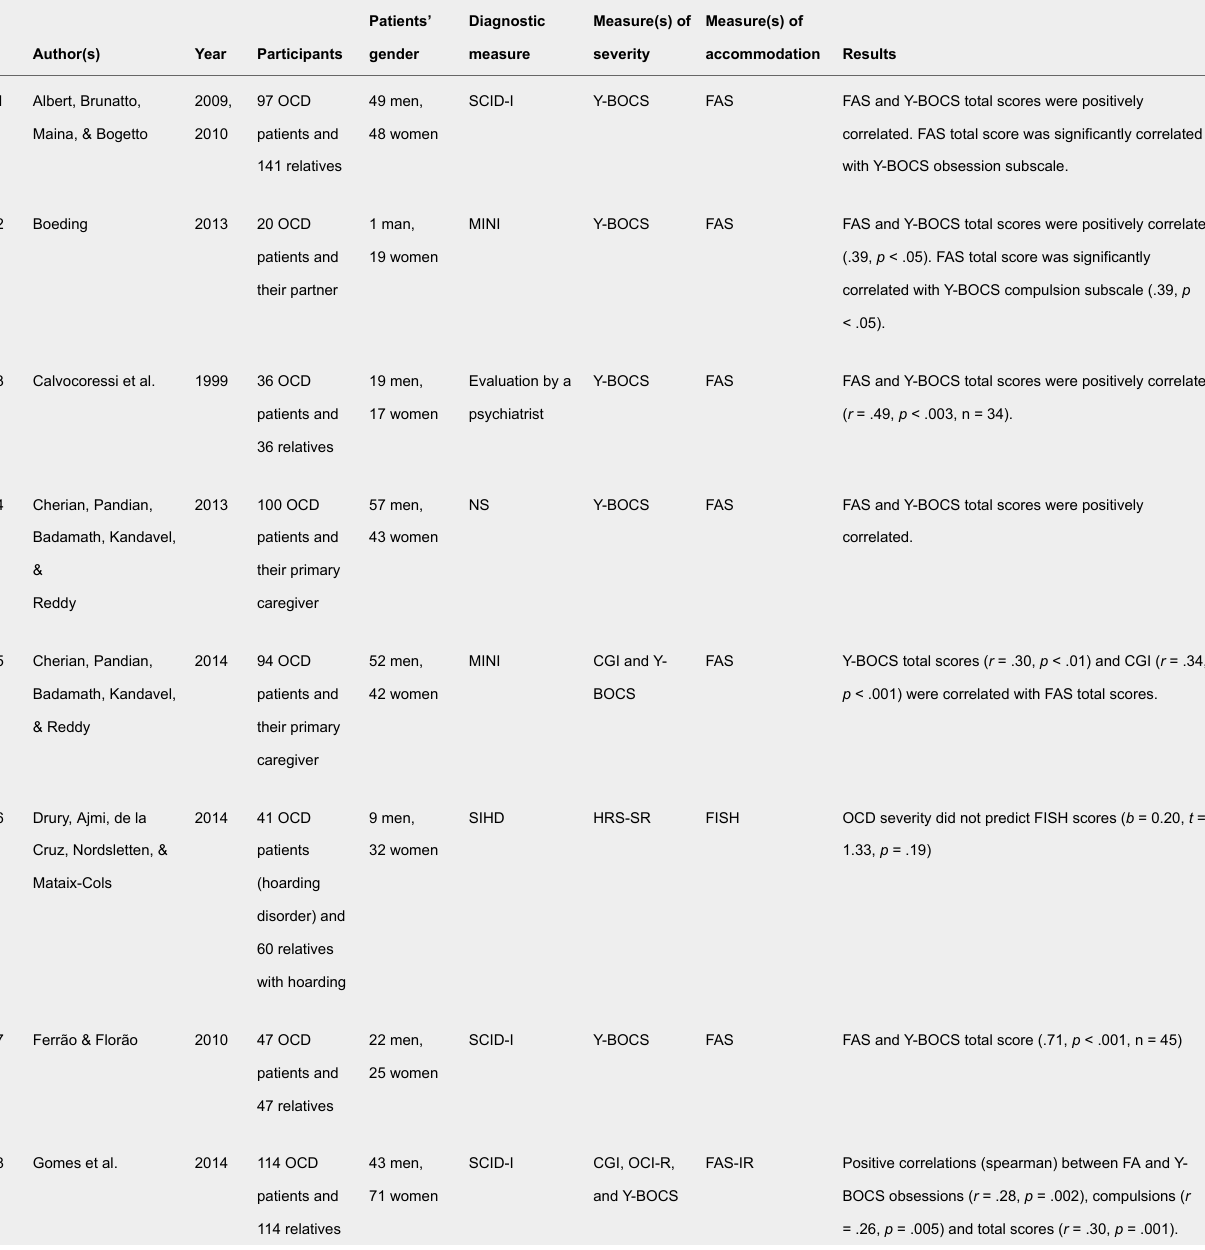
CGI, OCI-R, FAS-IR Positive correlations (spearman) between FA and Y- and Y-BOCS BOCS obsessions ( r = .28, p = .002), compulsions ( r = .26, p = .005) and total scores ( r = .30, p =